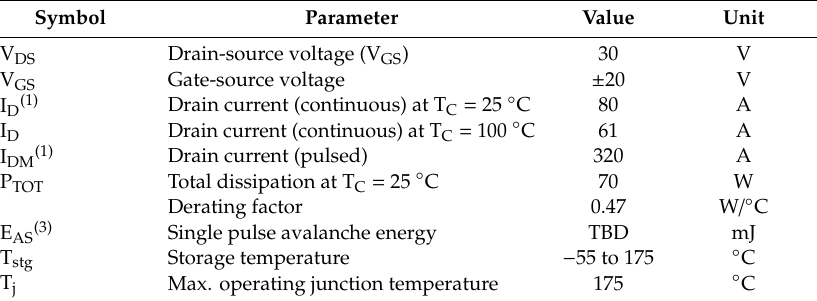
Figure A6. Operation Timing chart during Discharge Overcurrent / Short circuit charge / Overcurrent Protection with BM3451. Table A1. Specification of STD95N3L (LH6) Power MOSFET.